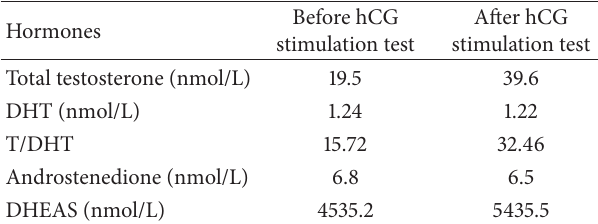
Table 1: Results of the hCG stimulation